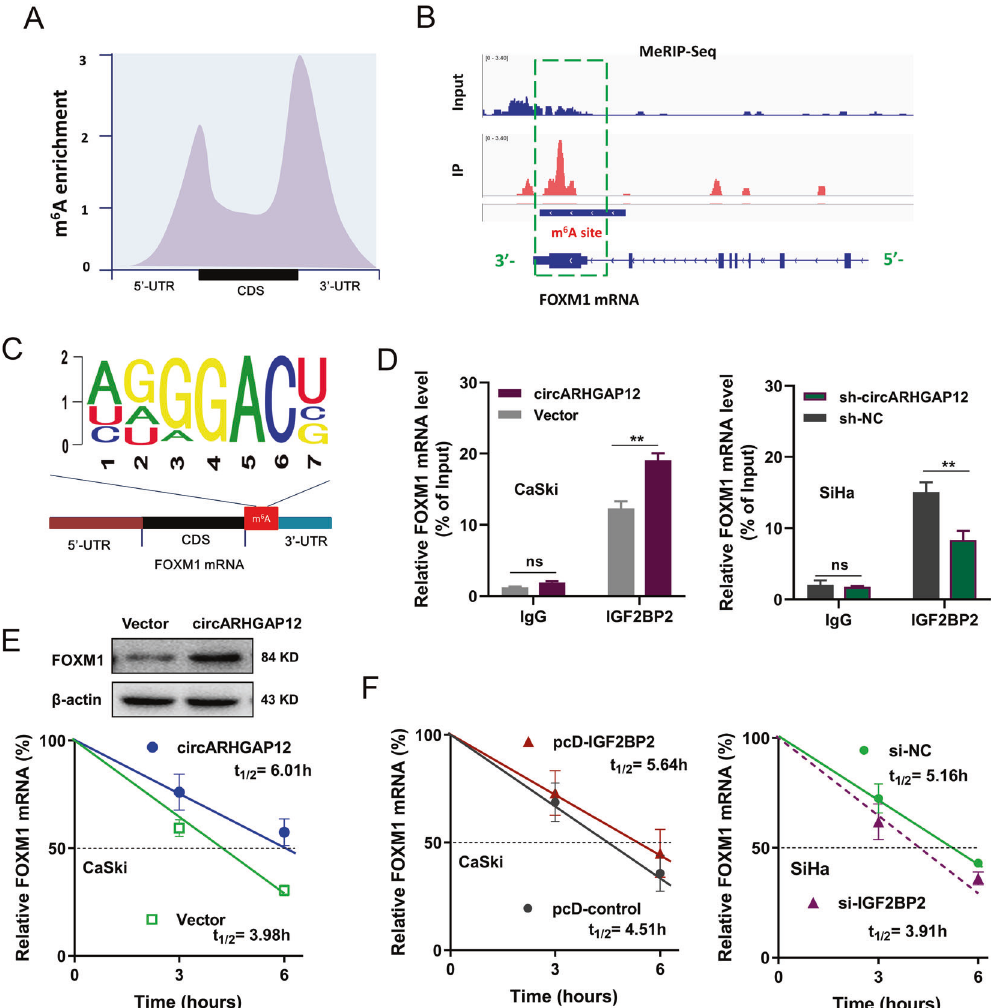
Fig. 5 circARHGAP12/IGF2BP2 enhanced the stability of FOXM1 mRNA. A MeRIP-Seq was performed to discover the potential m 6 A modi fi cation pro fi le in the cervical cancer cells. m 6 A sites were displayed in 5 ′ -UTR, 3 ′ -UTR, and CDS. B Schematic diagram based on